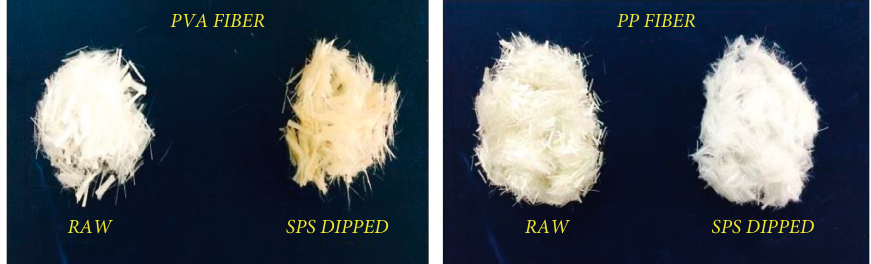
Figure 1: Colour changes in the PVA and PP fiber.